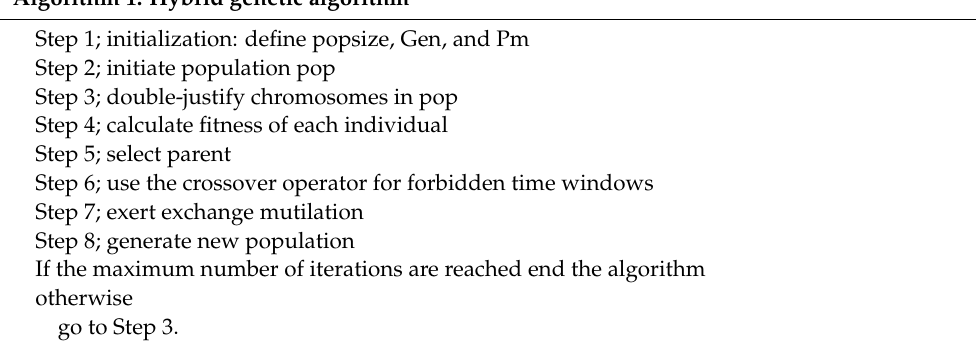
Algorithm 1: Hybrid genetic